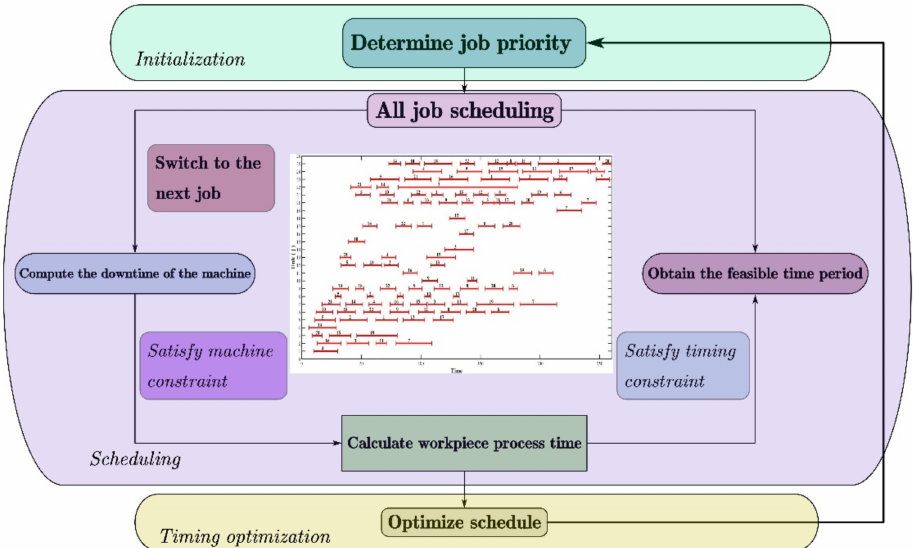
Figure 10. Schematic diagram for workshop scheduling